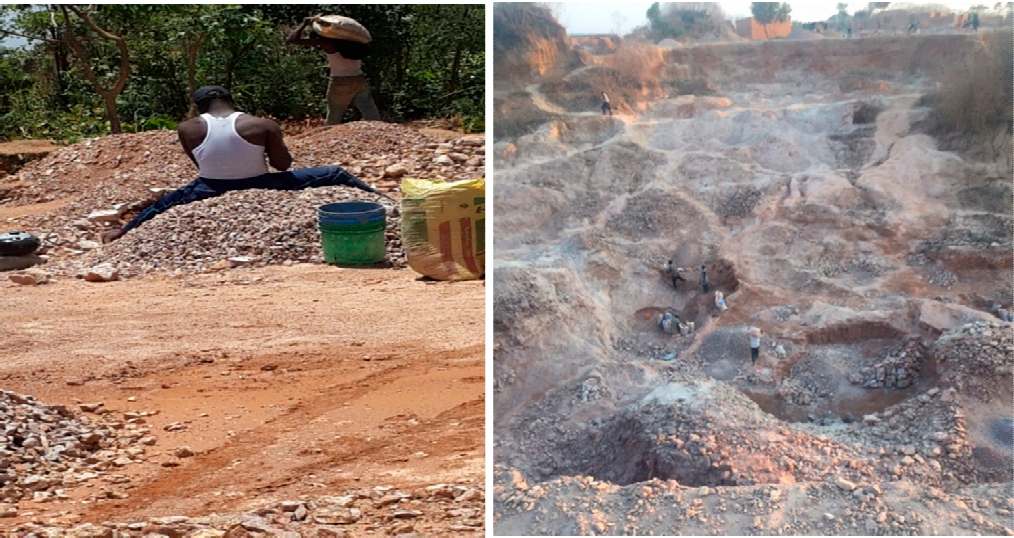
Figure 1. Left panel: An artisanal stone-crusher and a transporter of stones working in precarious conditions. Right panel: General view of the site where stones are manually extracted and then transported on shoulders towards the place where they are kept before being transformed into gravels that will be sold to the purchasers for building roads, bridges, houses.